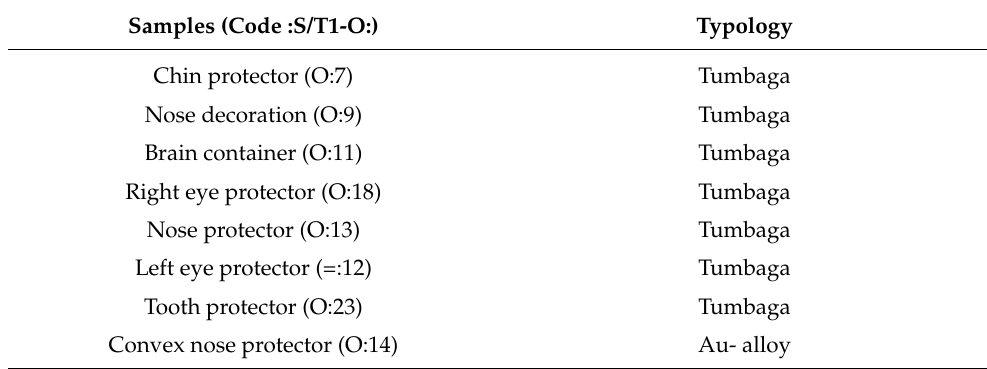
Table 1. List of samples examined. Each sample is indentified by “S/T1-0:” followed by a